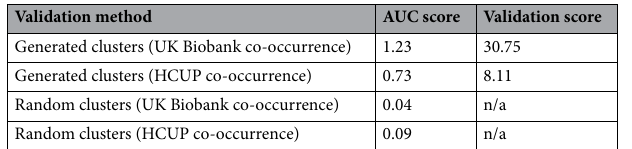
Table 1. AUC and validation scores for co-occurrence of cluster specific diseases in both UK Biobank and